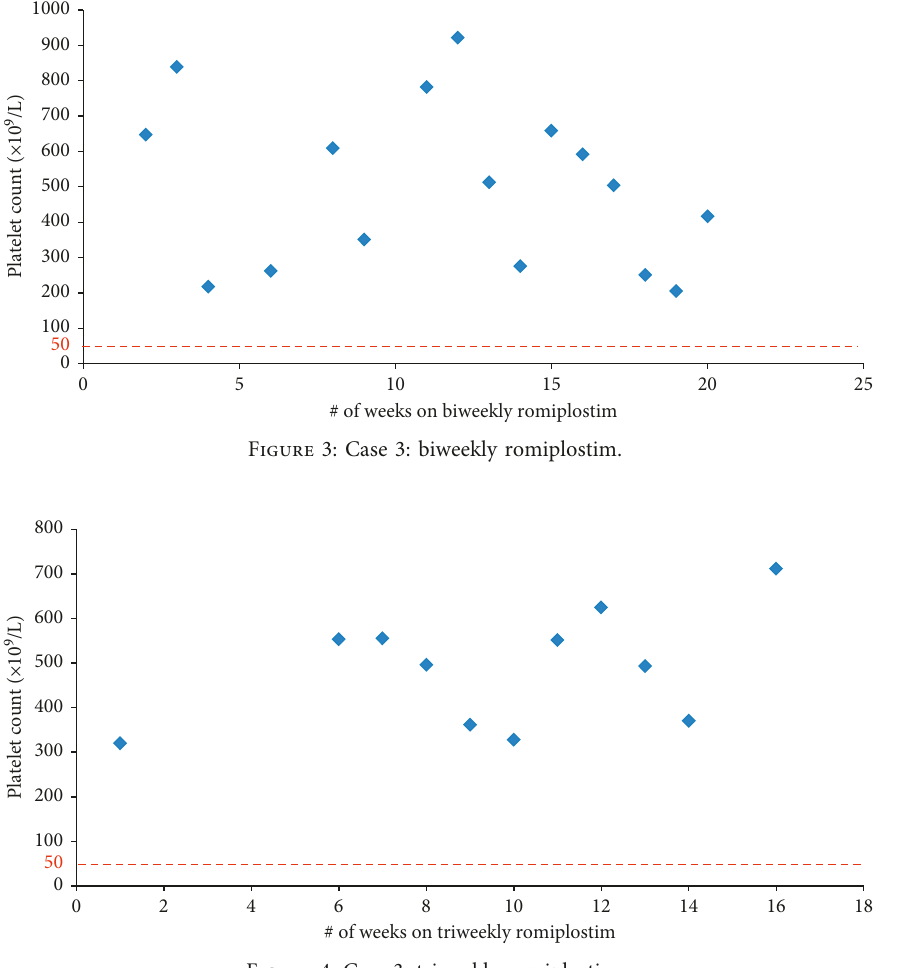
Figure 3: Case 3: biweekly